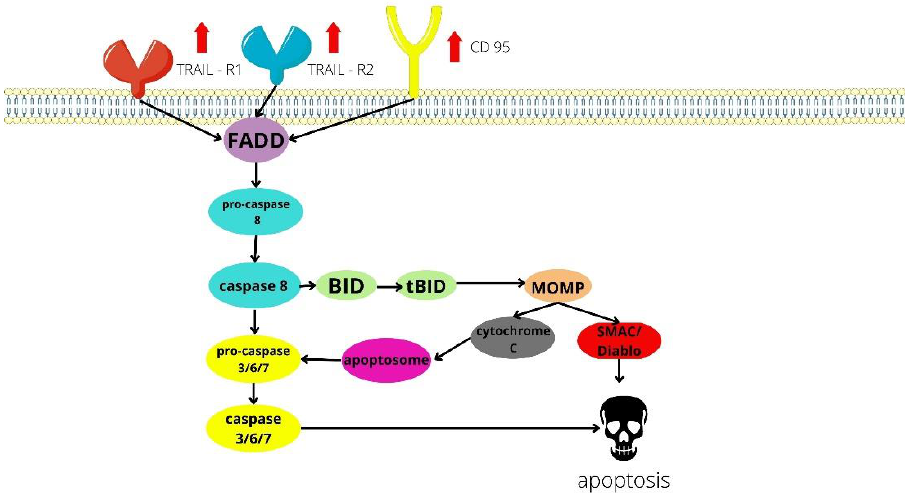
Figure 2. Diclofenacs impact on squamous cell carcinoma, including the cell membrane. Factor-related apoptosis-inducing ligand receptor 1 (TRAIL-R1), Factor-related apoptosis-inducing